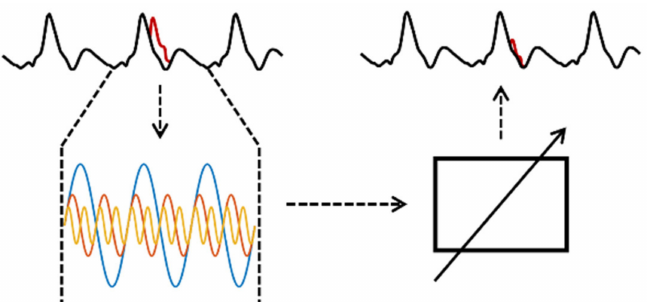
Figure 5. Principle of SFLC algorithm—black is the bioimpedance signal dZ/dt, red is the artifact in the current heartbeat cycle. Base frequency and harmonics depending on R-R-interval are combined by a weighting of frequencies and composition to the estimated signal. The different colors indicate the different